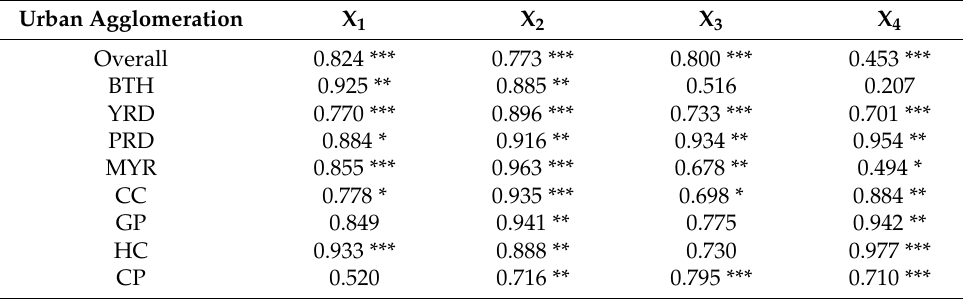
Table 6. The explanatory power of single factor in four